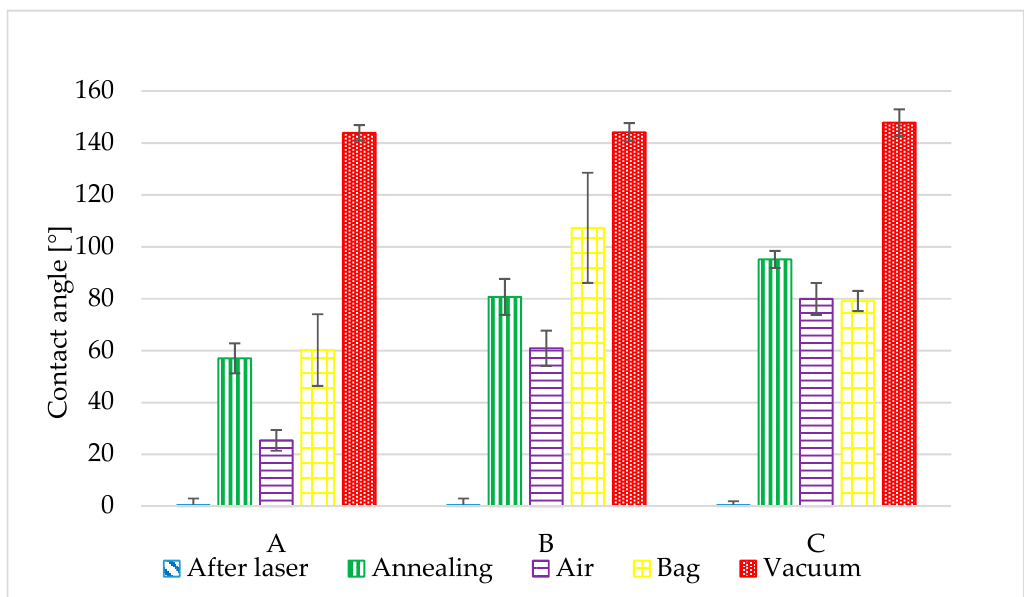
Figure 4. The contact angles after laser processing and at the end of the measurement period for three different laser structures A, B, C.